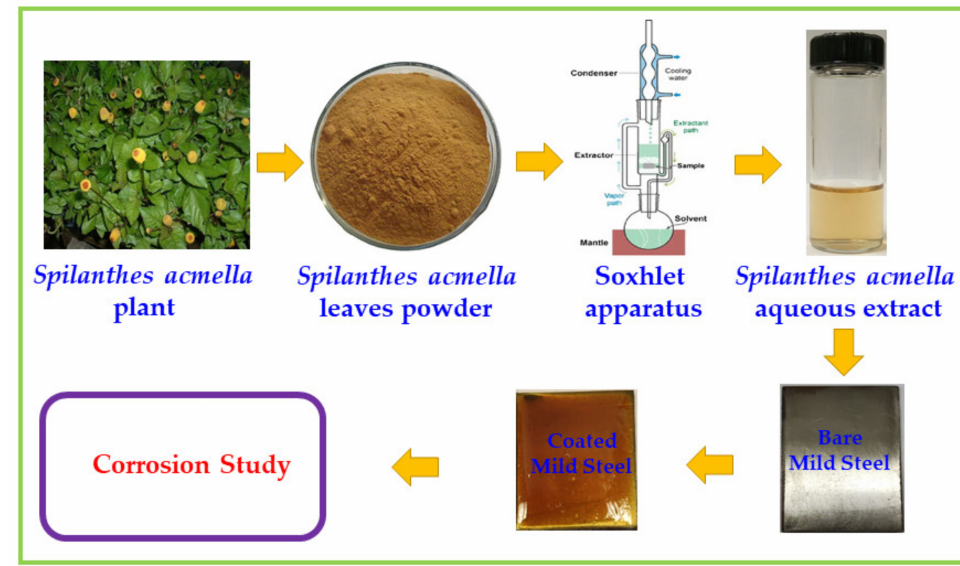
Figure 1. Graphical representation of extraction and anticorrosive applications of Spilanthes acmella (SA)